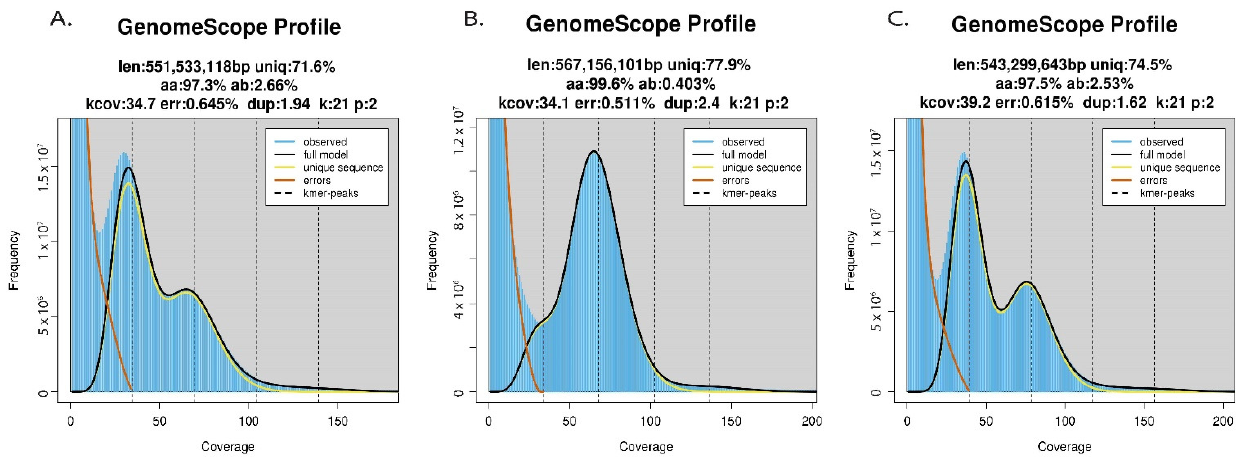
Figure 3. GenomeScope2.0 output showing variation in genome-wide heterozygosity levels among Mexican vanilla accessions: ( A ) MEX41, ( B ) MEX67 and ( C ) MEX79. Table 2. Genomic structure attributes of reference ‘Daphna’ genome and Mexican V. planifolia sam- ples, inferred through GenomeScope2.0 and Smudgeplot (ploidy).